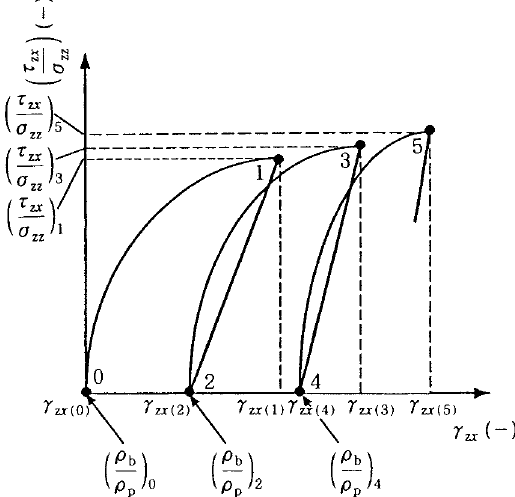
Fig. 16 . Schematics of stress-strain curve using Eqs. (8) and (9)